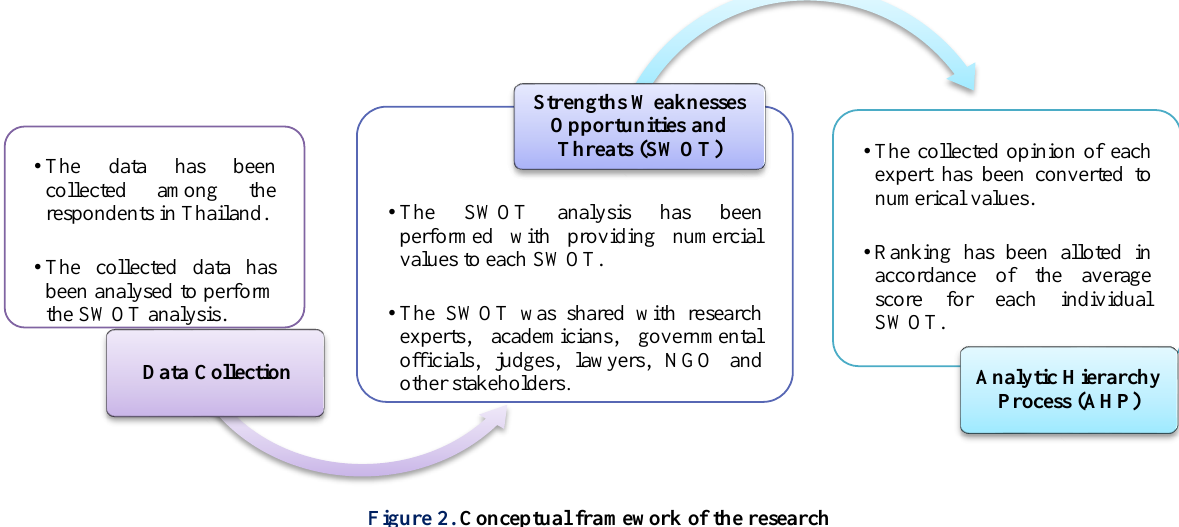
Figure 2. Conceptual framework of the